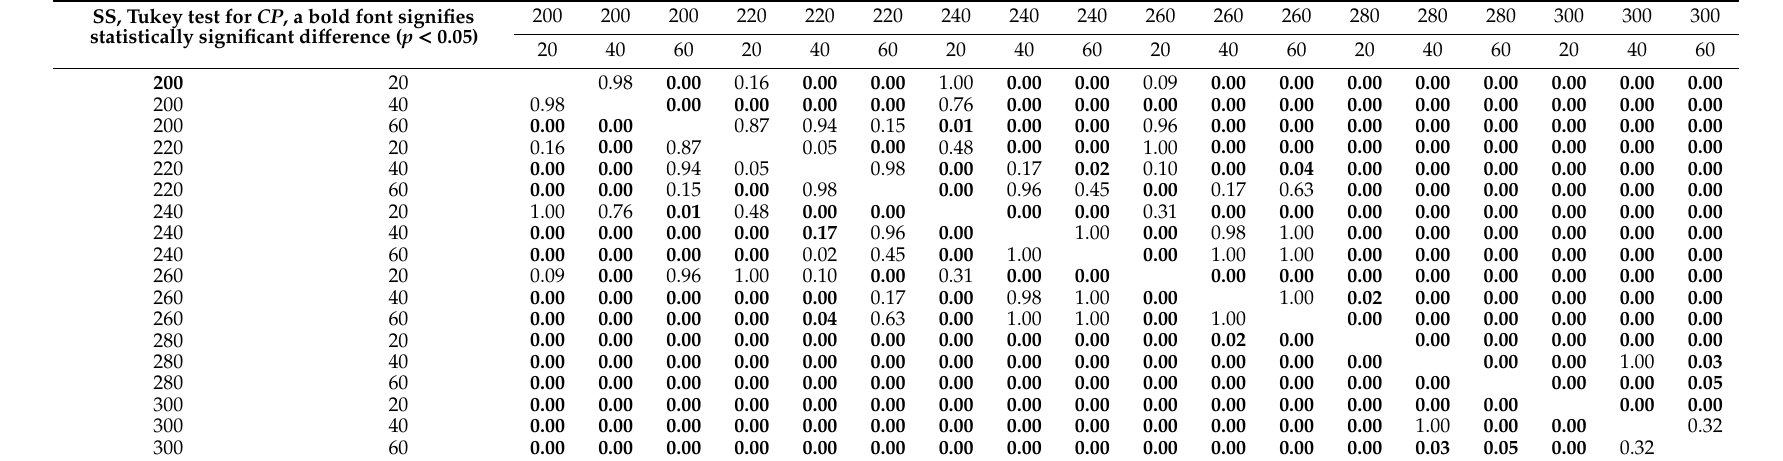
Table A12. Analysis of variance for combustible parts content of sewage sludge.